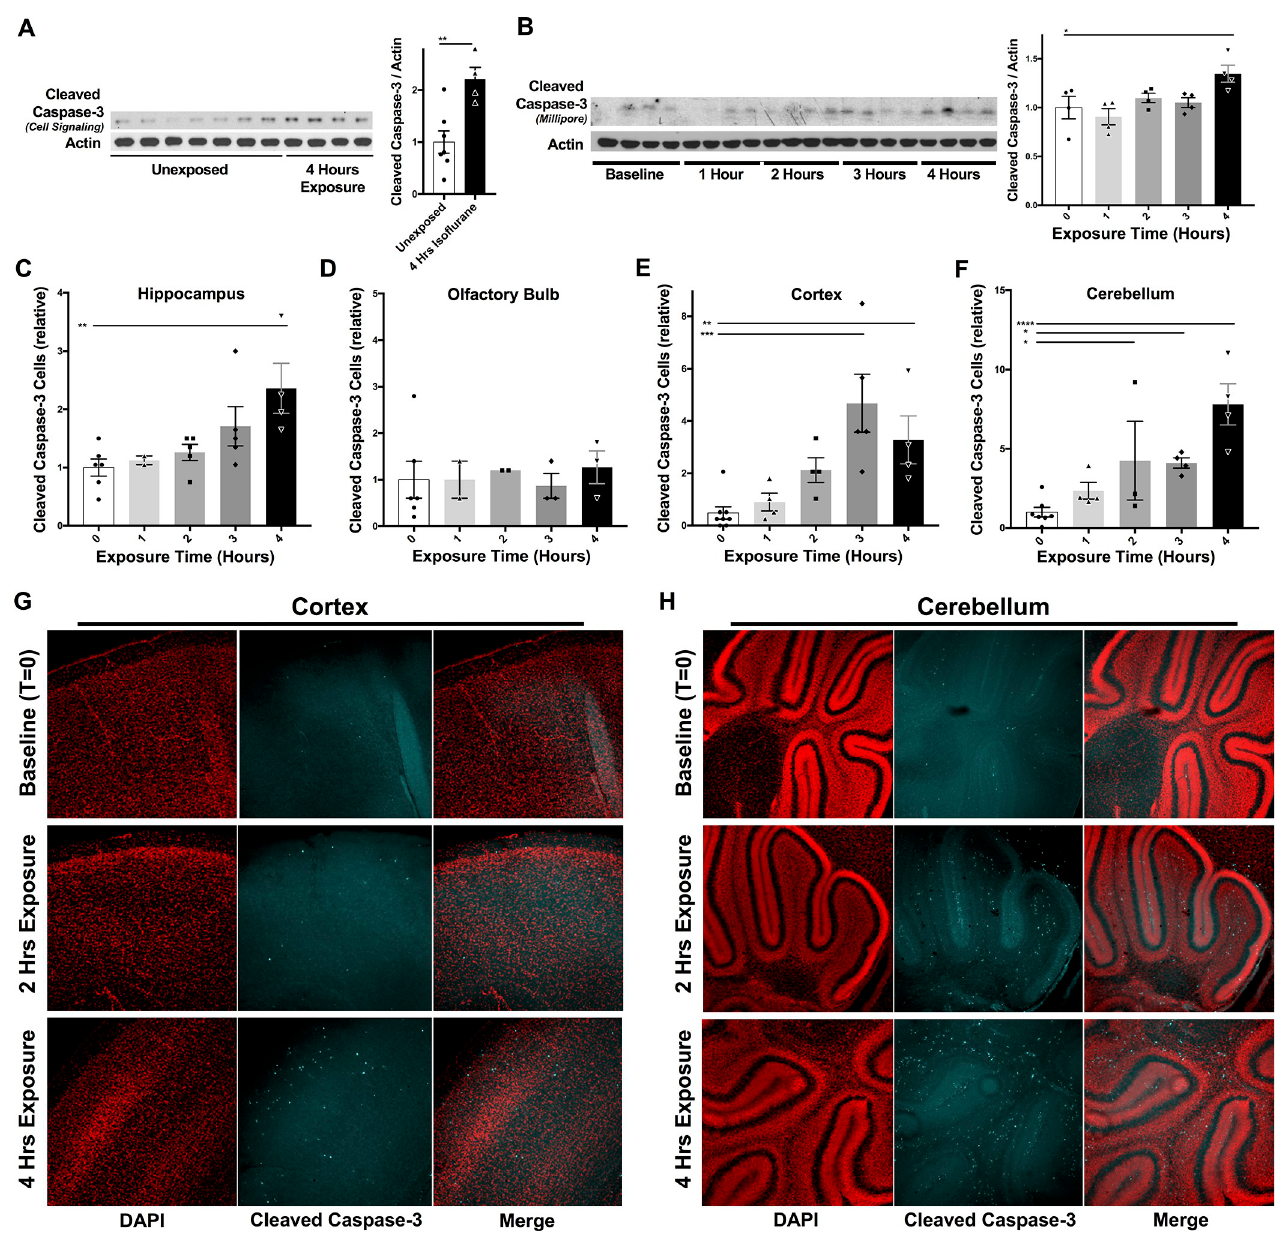
Fig 3. Anesthesia induced apoptosis in P7 neonatal mice. ( A ) Western blot probing for cleaved caspase-3 in brain lysates from control P7 mice (unexposed) and P7 mice exposed to 1.5% isoflurane for 4 hours. �� p < 0.005, pair-wise t-test. n = 7 and 4 for baseline and exposed, respectively. ( B ) Western blot probing for cleaved caspase-3 in brain lysates from P7 mice exposed to 1.5% isoflurane for 0 to 4 hours. ANOVA p-value < 0.0008; �� p < 0.005, post-hoc pair-wise t-test. n = 4 at each timepoint. ( C-F ) Quantification of cleaved caspase-3 positive cells in the hippocampus ( C ), olfactory bulb ( D ), cortex ( E ), and cerebellum ( F ) of P7 neonatal mice exposed to 1.5% isoflurane for 0–4 hours. One-way ANOVA: hippocampus: � p < 0.02; olfactory bulb: non-significant; cortex ��� p = 0.0006; cerebellum ��� p = 0.0007. In each panel � p < 0.05, �� p < 0.005, ��� p < 0.0005 in post-hoc pair-wise t-tests. Error bars represent SEM. ( G-H ) Representative confocal images of immunofluorescent staining for cleaved caspase-3 in the cortex ( G ) or cerebellum ( H ) of animals exposed to 1.5% isoflurane for 0, 2, or 4 hours. The red channel represents DAPI, a fluorescent DNA binding molecule. The cyan channel represents the anti-cleaved Caspase-3 antibody